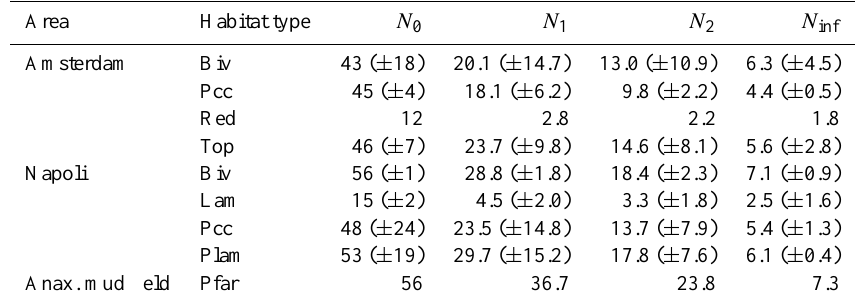
Table 5. Diversity indices (Hill numbers) of nematode communities from different microhabitats (Biv: bivalve shells; Pcc: periphery of carbonate crusts; Red: reduced sediments; Top: summit of the mud volcano; Lam: Lamellibrachia microhabitat; Plam: periphery of Lamelli- brachia ; Pfar: far periphery).